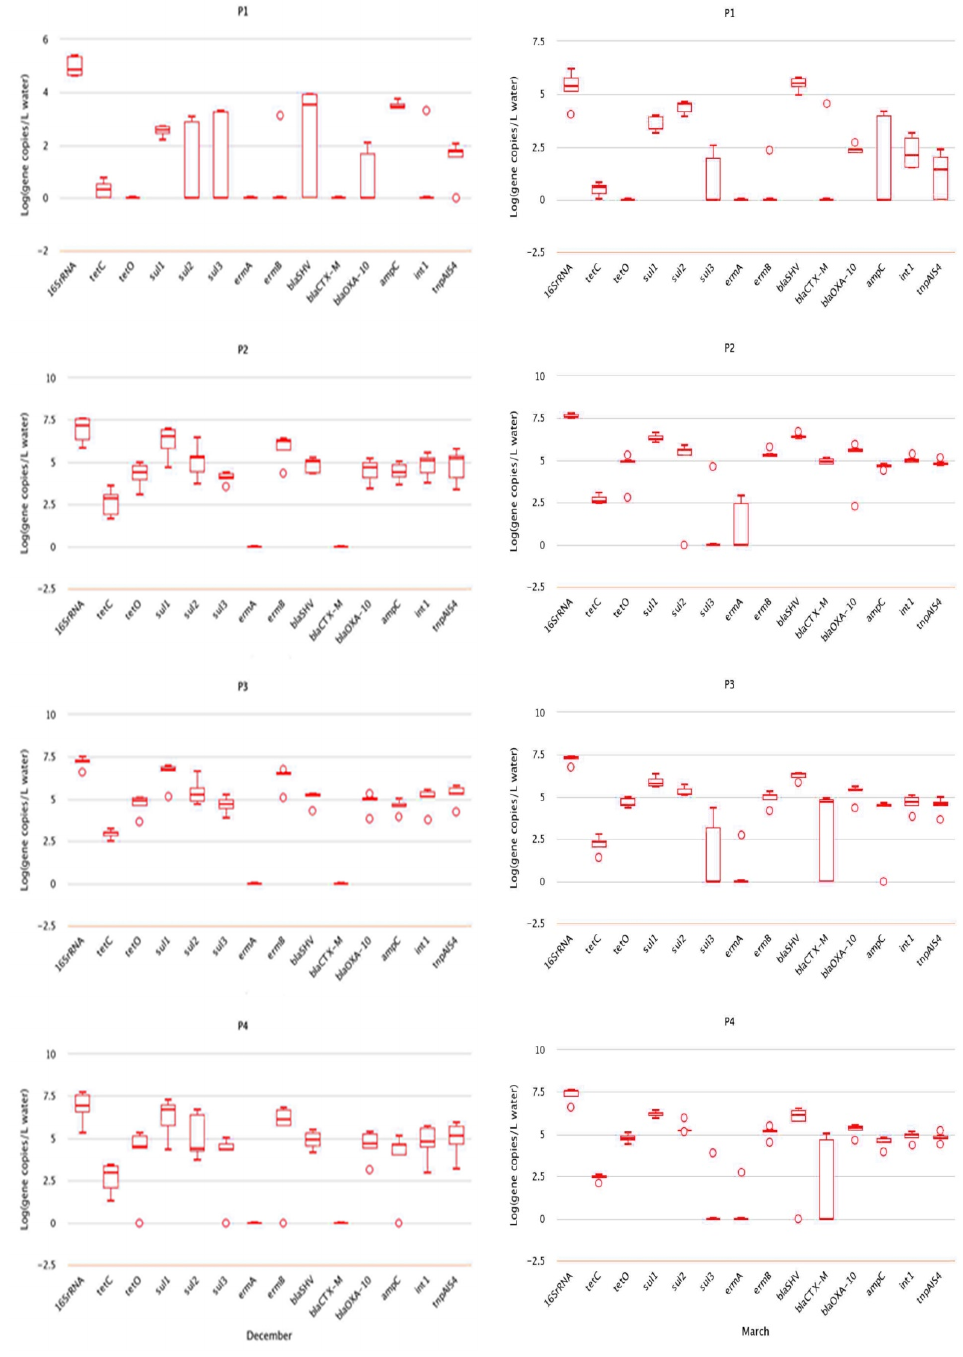
Figure 3. Abundance of resistance genes in samples collected in December and March. The absolute abundance of β -lactam resistance gene blaSHV was highest both in water samples (5.12 × 10 6 copies/L) and soil samples (4.17 × 10 6 copies/g) collected